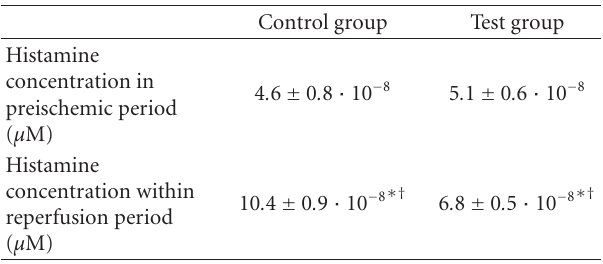
Table 1: Histamine concentrations in the control (without glucagon) and test (in the presence of glucagon) groups taken during preischemic and reperfusion